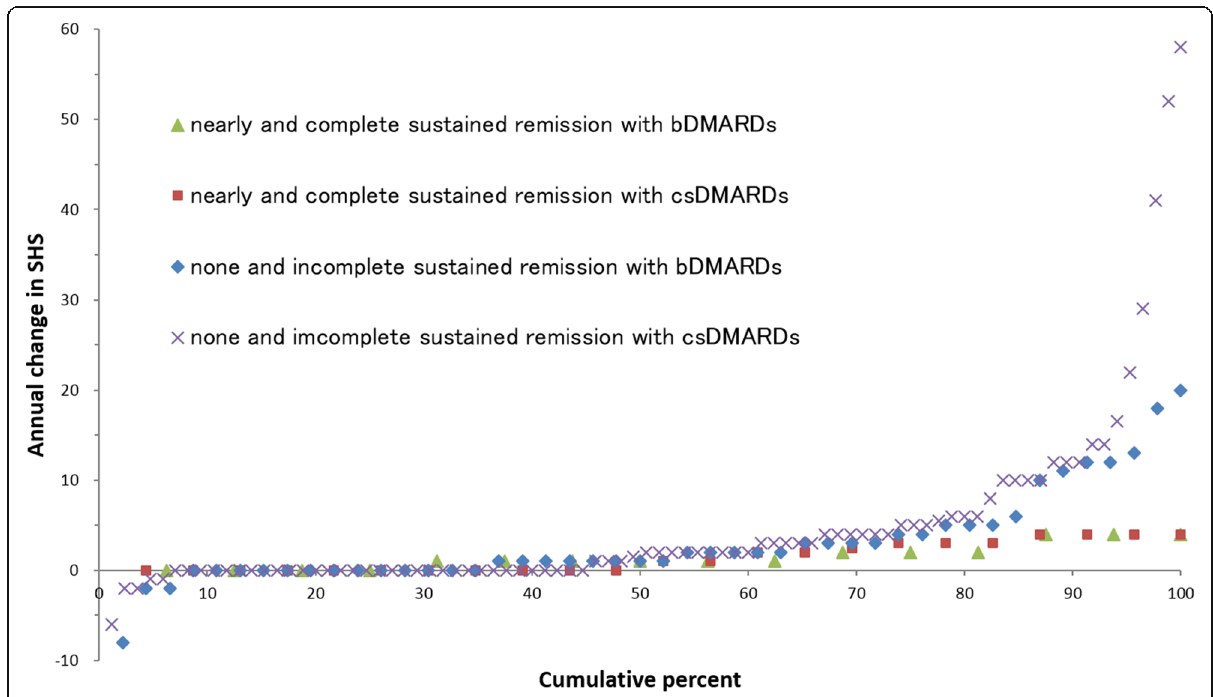
Fig. 5 Cumulative probability plot for patients in sustained remission according to SDAI criterion during follow-up period compared bDMARDs with